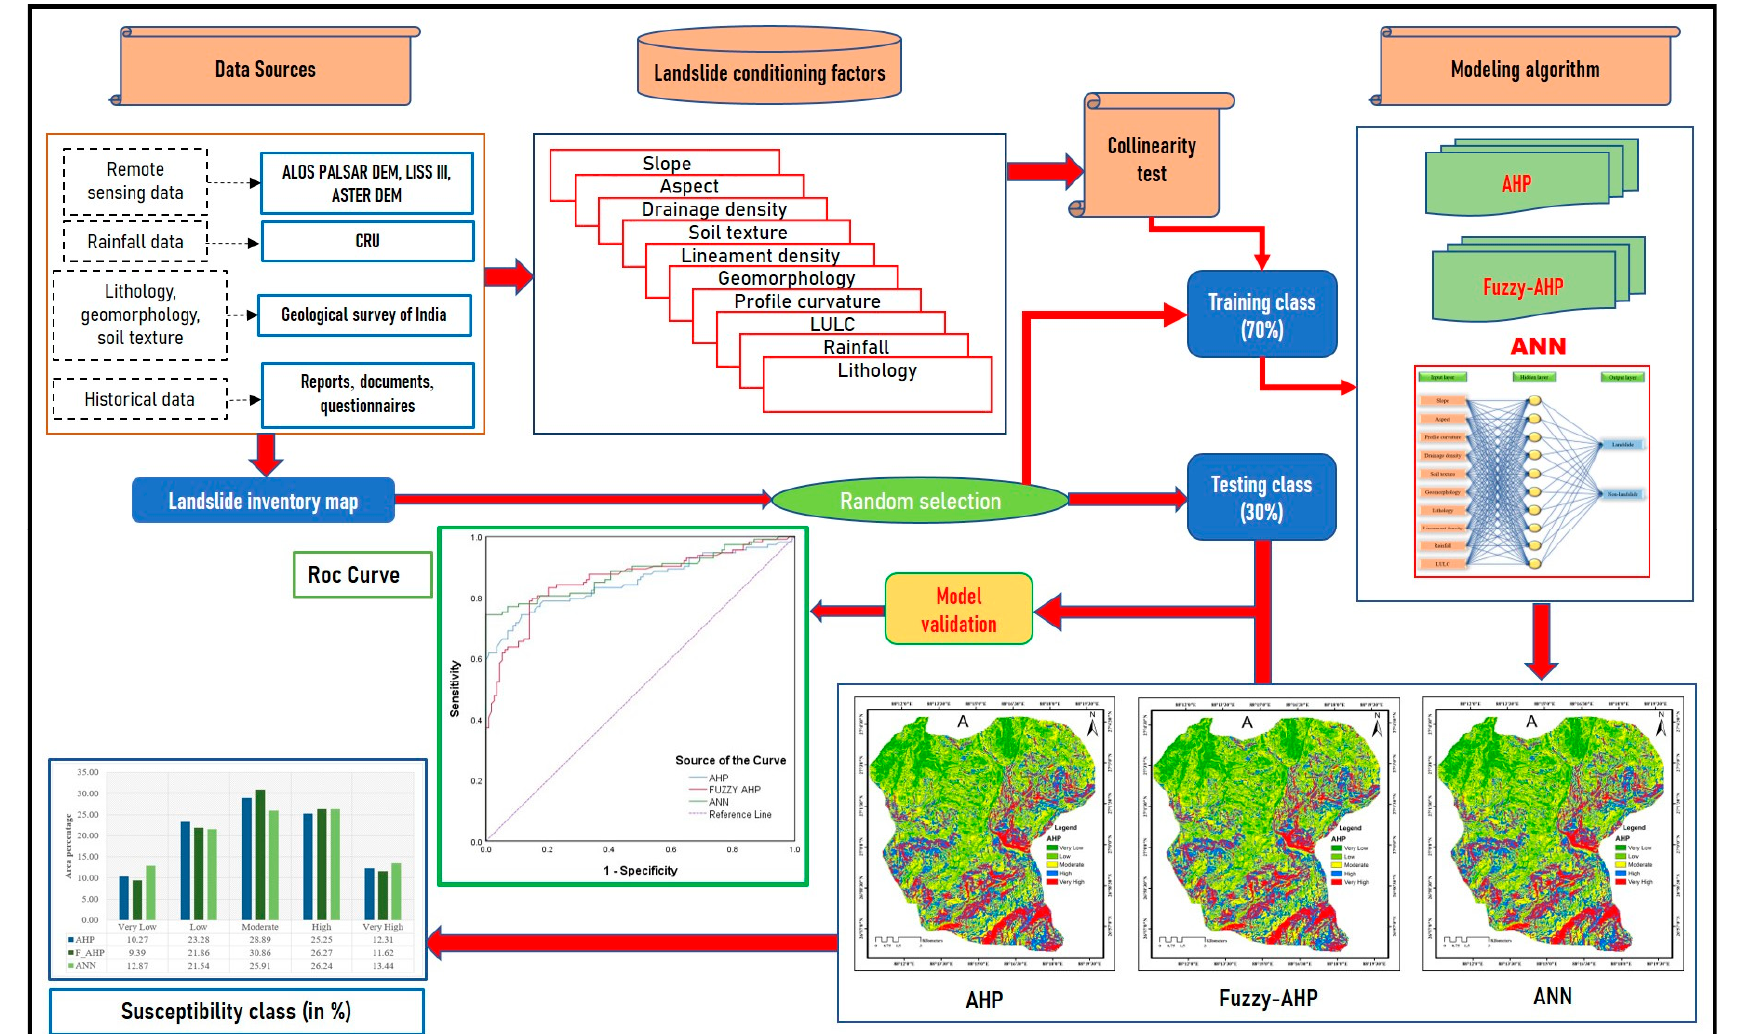
Figure 2. Graphical representation of overall methodology.